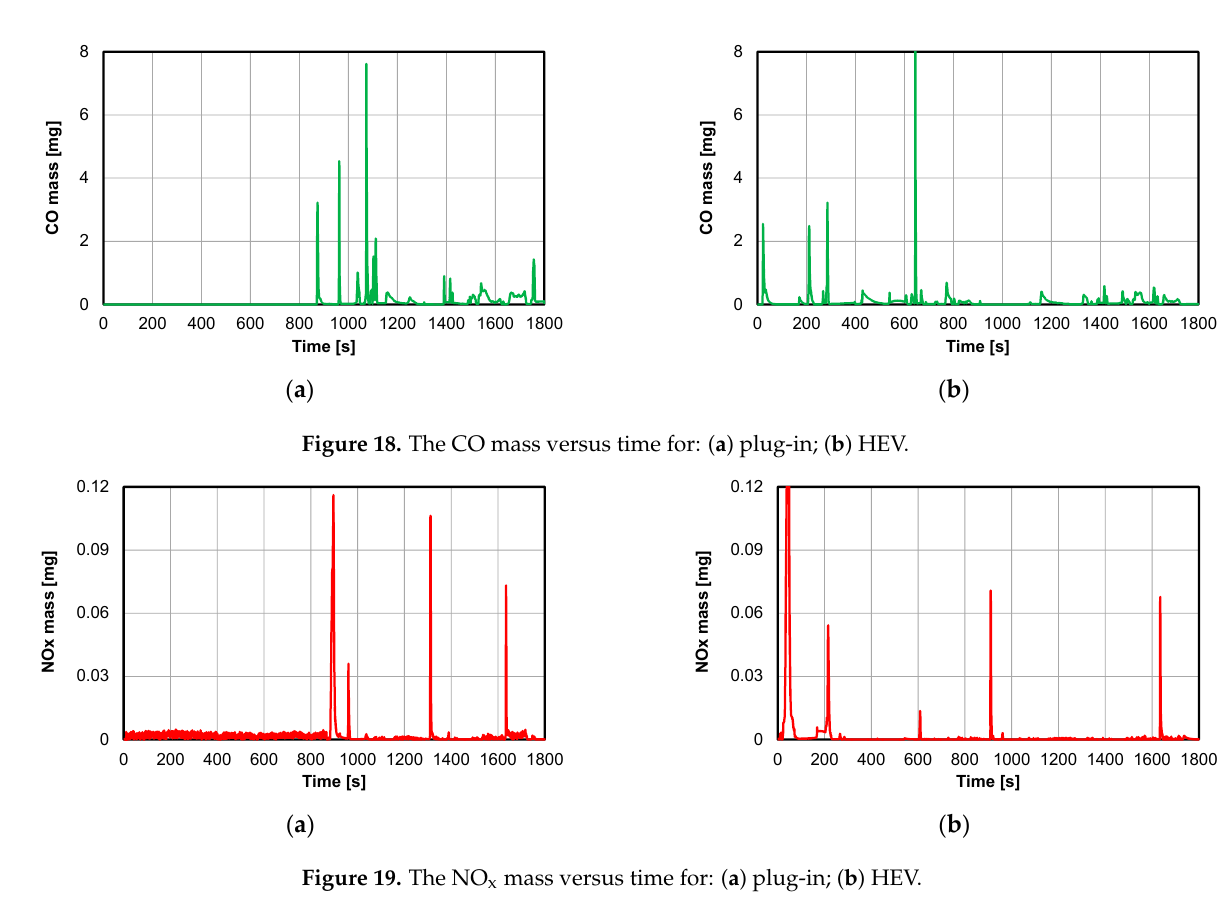
Figure 20. The THC concentration versus time for: ( a ) plug-in; ( b ) HEV.